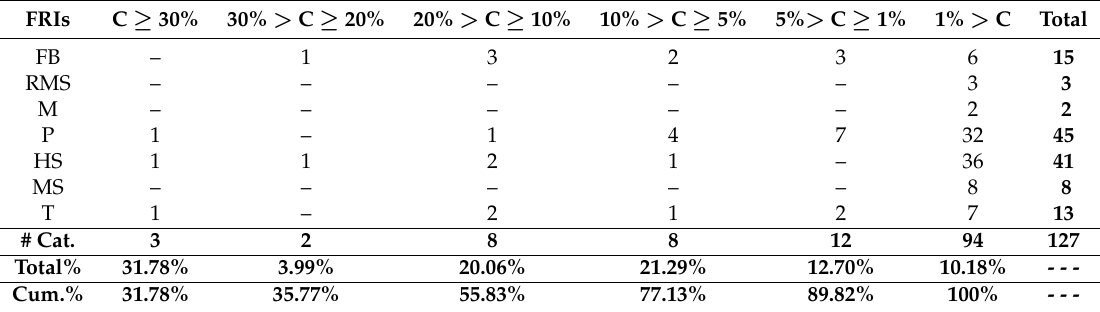
Categories (C) ordered by their percentage of participation in each First Response Institution